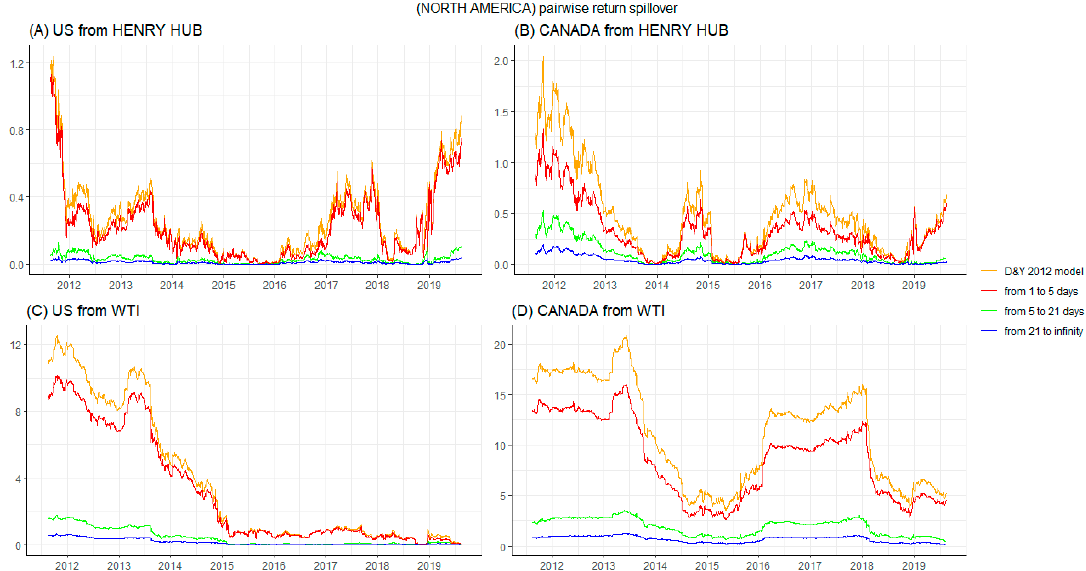
Figure A1. Pairwise directional return spillover of DY12 and BK18 in North America. Notes: US from HENRY HUB indicates the return spillover from natural gas to US; CANADA from HENRY HUB indicates the return spillover from natural gas to Canada; US from WTI indicates the return spillover from crude oil to US; CANADA from WTI indicates the return spillover from crude oil to Canada.